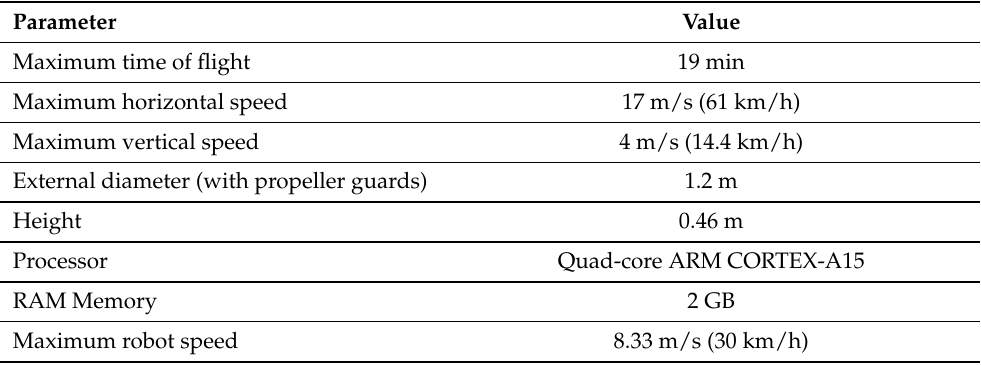
Table 1. The main characteristics and parameters of the